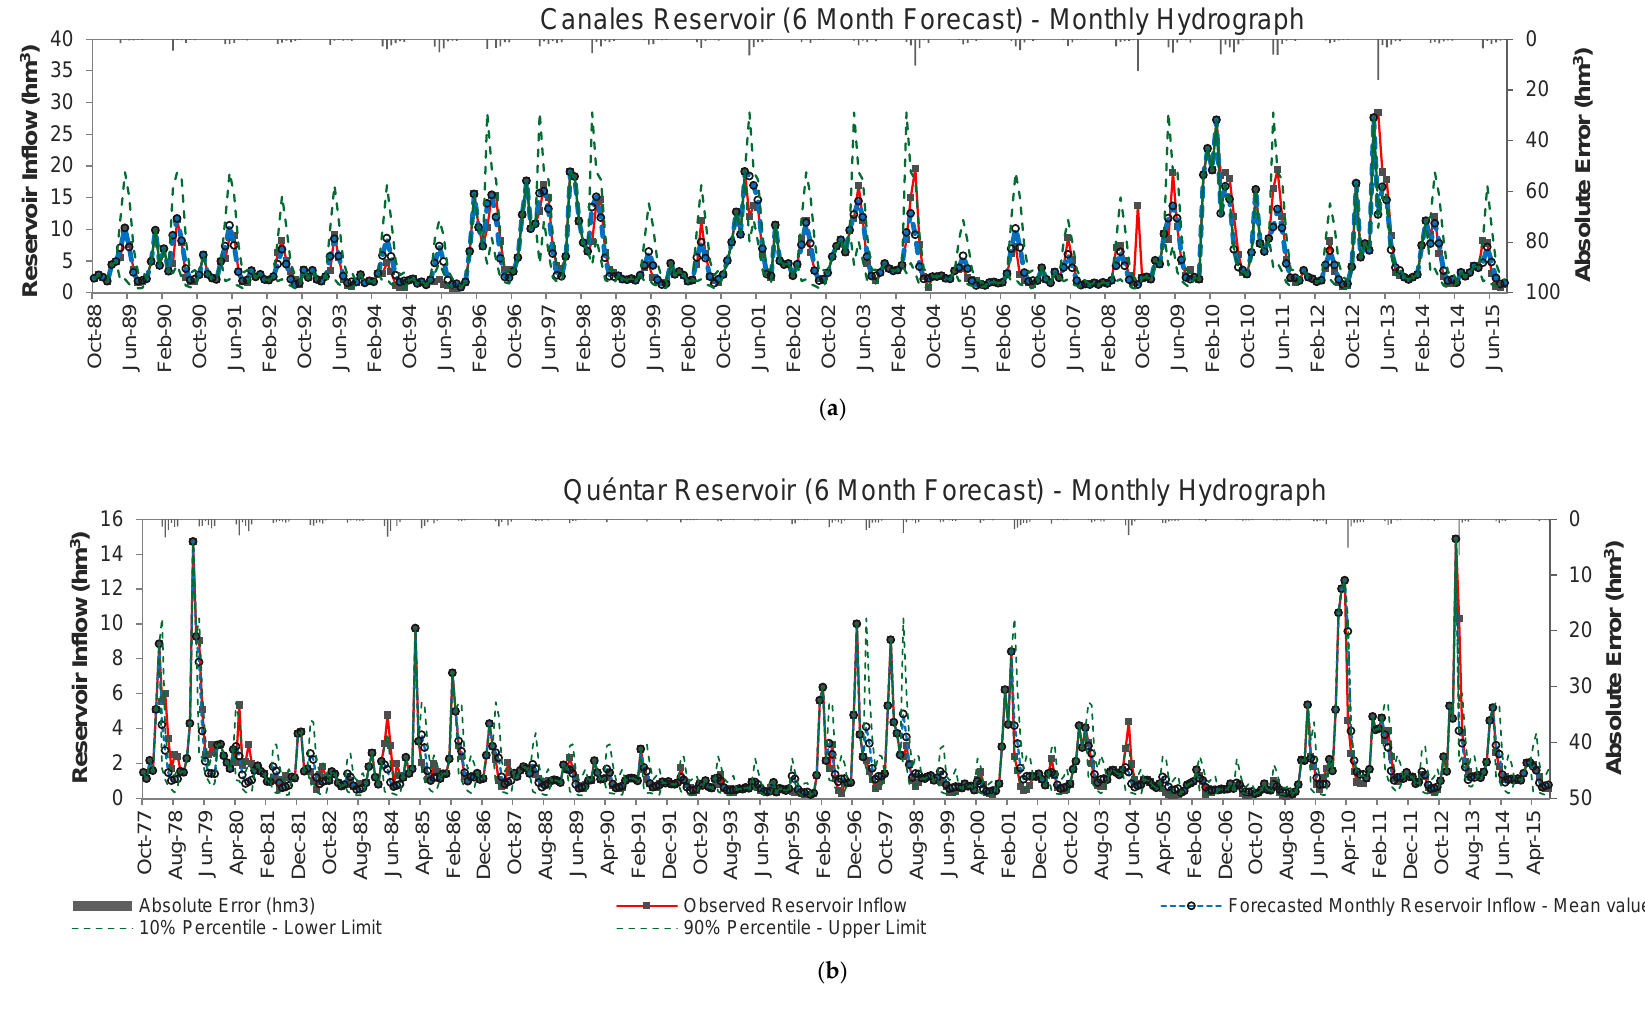
Figure 9. Observed monthly streamflows (hm 3 ) and predictions using the model with the first six months of observed data of the hydrological year and 10th and 90th percentiles (lower and upper limits) (hm 3 ) of the ( a ) Canales reservoir and ( b ) Quéntar reservoir.